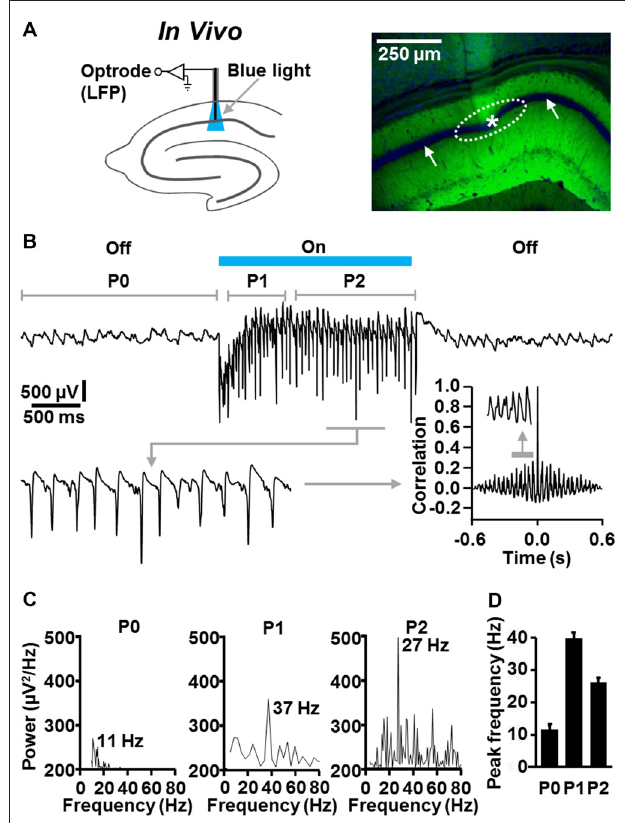
FIGURE 4 | Temporally precise optogenetic induction and termination of fast CA1 network oscillations in slightly anesthetized NEX-Cre-ChR2 mice. (A) Experimental setting and photograph illustrating the position of the recording tip of the optrode (asterisk) and the calculated illumination spot in the CA1 stratum pyramidale (dotted ellipse) in the experiment shown in ( B ; right panel: green (EYFP-generated) fluorescence signal reports ChR2 expression; blue fluorescence signal reports nuclear DAPI staining, which is best visible in the pyramidal cell body layer (white arrows)). (B) Representative recording trace, enlarged portion of the trace, and autocorrelogram depicting the oscillatory network activity in the absence and presence of ChR2 activation by blue laser light (488 nm; 4 mW/mm 2 ). (C) Power spectra for P0, P1, and P2 of the rhythmic network activity shown in (B) . (D) Average data from spectral analyses ( n =